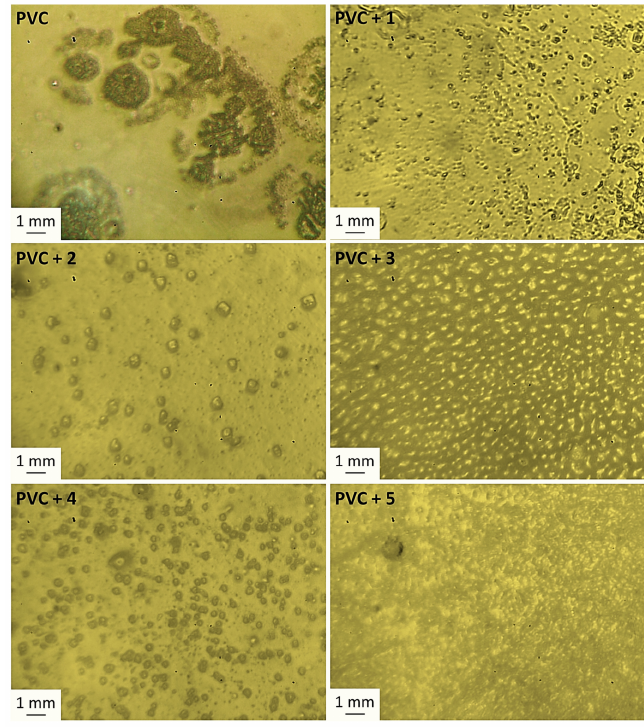
Figure 8. Microscope images of irradiated PVC films.